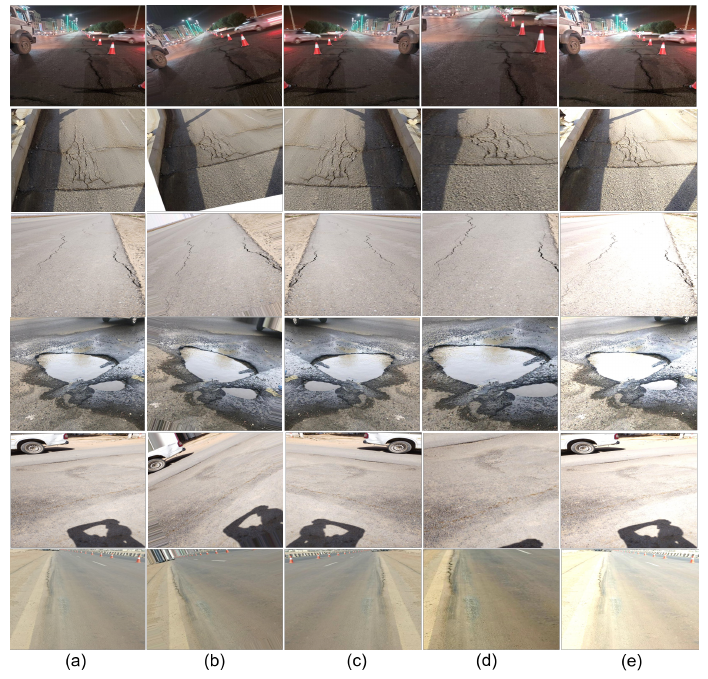
Figure 4. Example of augmented images: ( a ) original image, ( b ) rotation 23 degrees, ( c ) horizontal flip, ( d ) zoom [0.5], and ( e ) brightness [0.5,